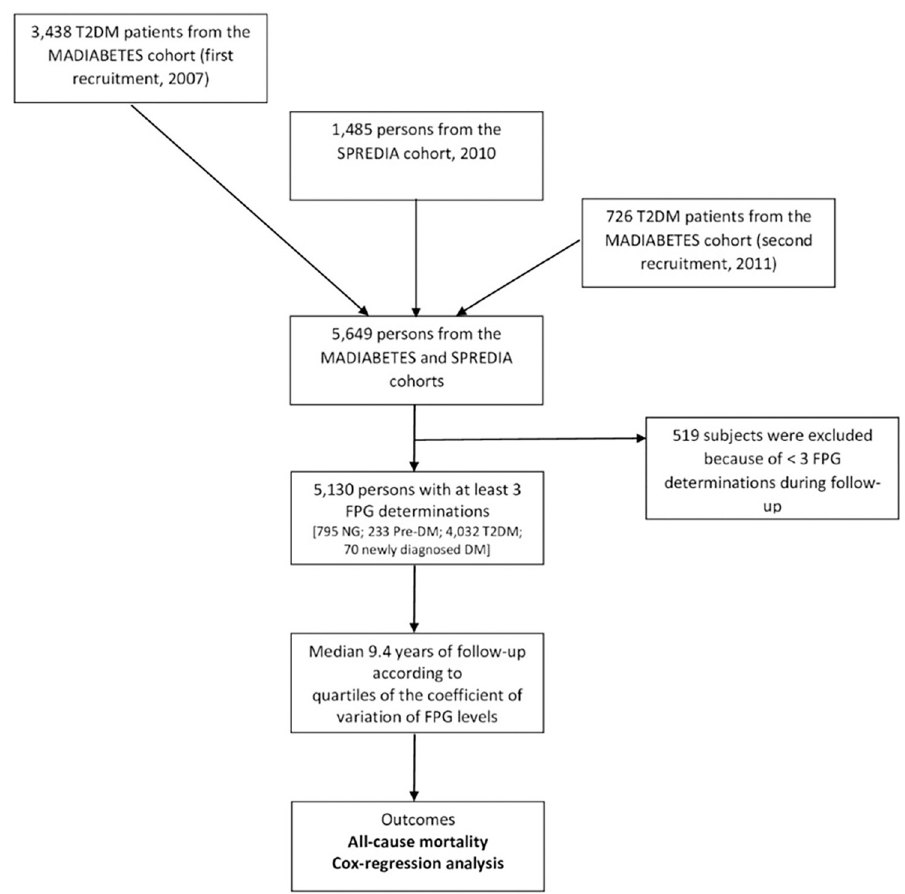
Fig 1. Flow chart of study participants. FPG: fasting plasma glucose; NG: normoglycemia; Pre-DM: prediabetes; T2DM: type 2 diabetes mellitus.